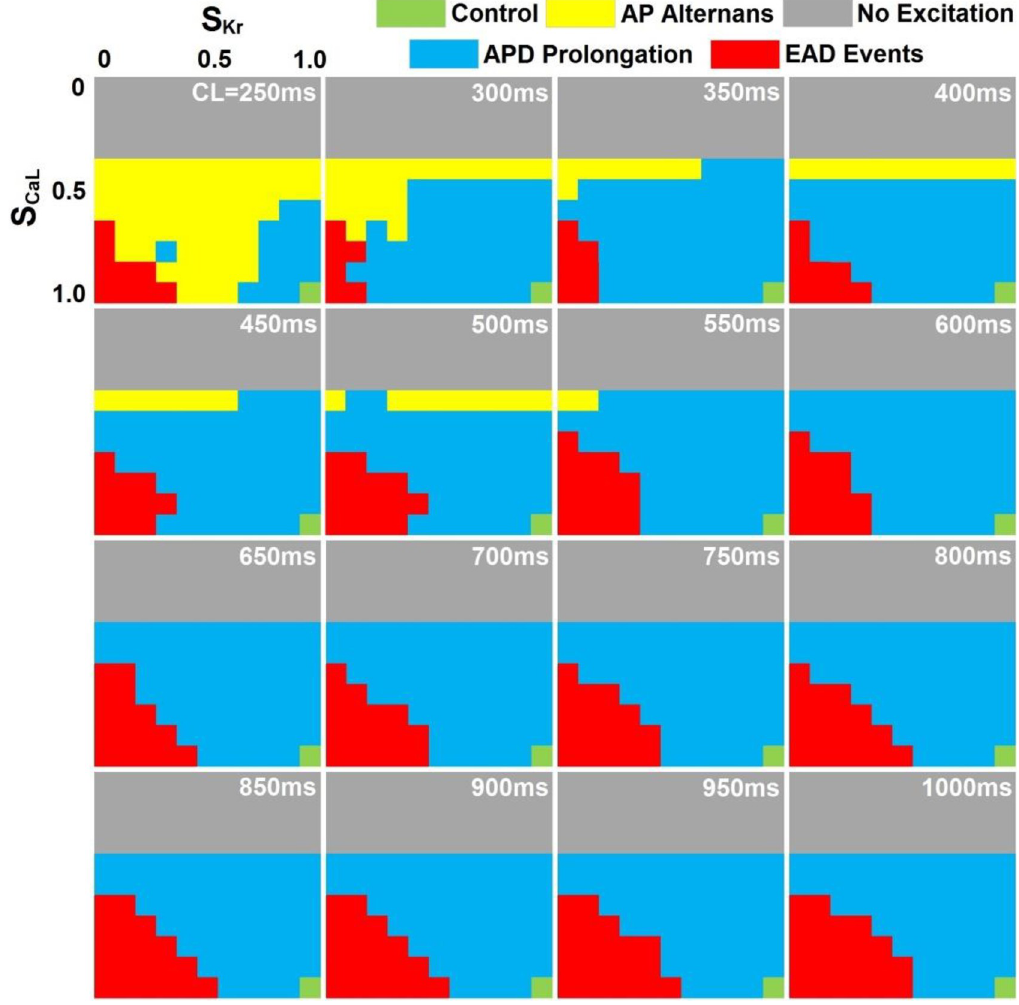
Fig 2. Parameter space mapping of S Kr , S CaL and CL, color-coded according to spatiotemporal excitation patterns of the PVS (control: green; gray: no excitation; blue: action potential (AP) prolongation; yellow: AP alternans without early afterdepolarization (EAD) events; red: EAD events). S Kr : the scaling factor of I Kr inhibition; S CaL : the scaling factor of I CaL inhibition; CL: pacing cycle